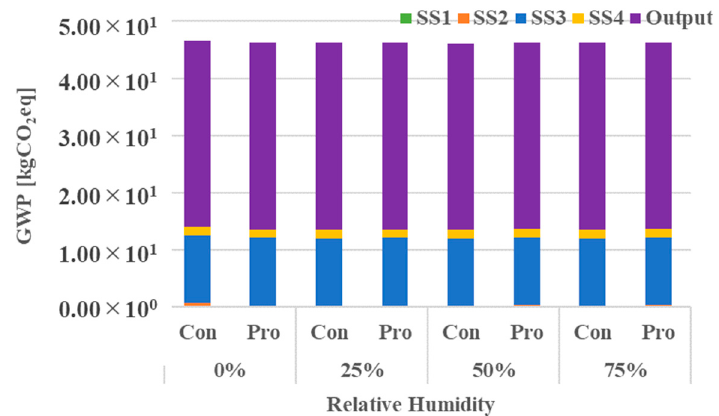
Figure 12. Result of GWP in the sensitivity analysis.